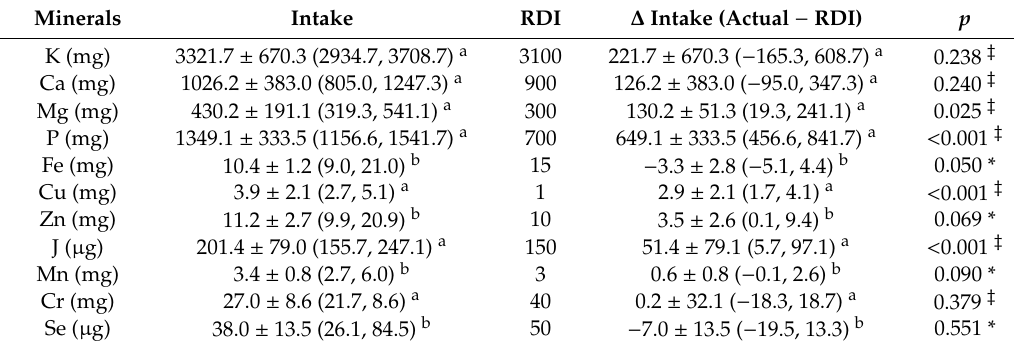
Table 5. Mineral intake of deaf